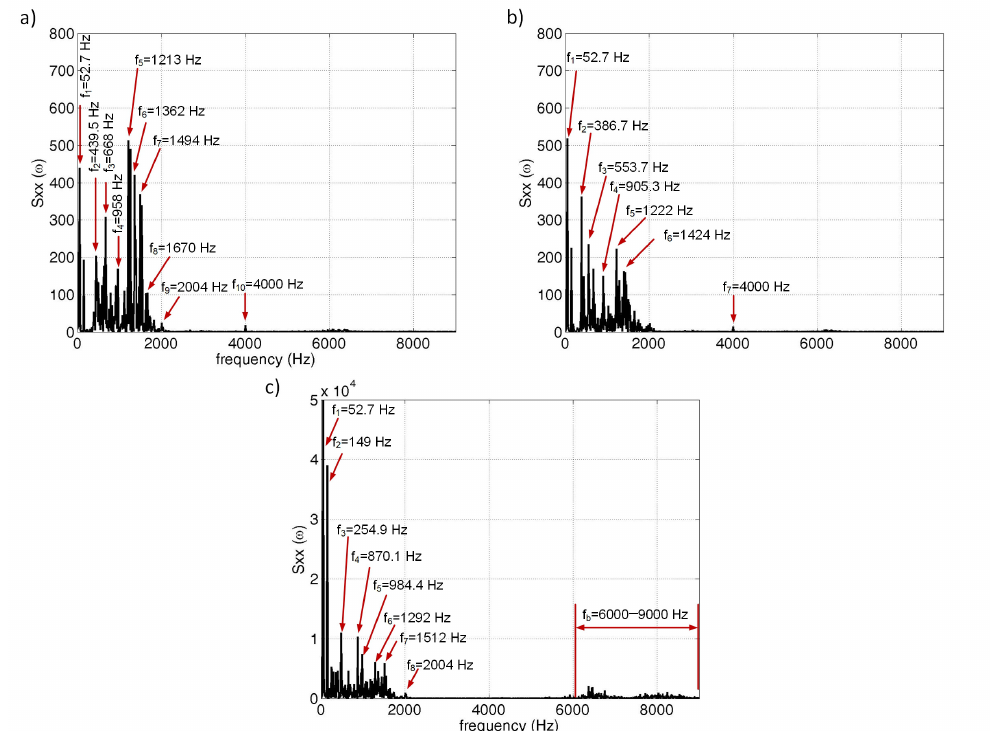
Figure 12. Power spectra by FFT algorithm (( a ) frequency power spectrum of vibration signal of three aggregates without drill bit, ( b ) frequency power spectrum of vibration signal of three aggregates with drill bit, ( c ) frequency power spectrum of the andesite rock disintegrating vibration